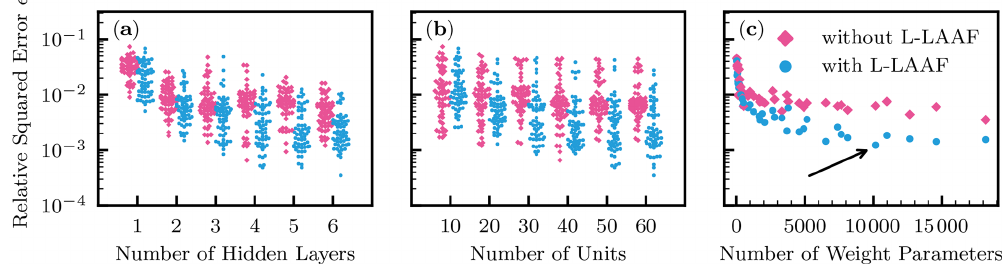
Figure 6. Homogeneous soil. Relative squared error in terms of volumetric water content (cid:15) θ for different numbers of hidden layers (a) and units (b) with and without the use of the layer-wise locally adaptive activation function (L-LAAF). In panel (c) , the averaged (cid:15) θ values were computed for each neural network architecture, and the values were plotted against the number of the weight parameters of each neural network. The arrow indicates the lowest averaged (cid:15) θ , which corresponds to neural networks with five hidden layers with 50 units used in Fig.